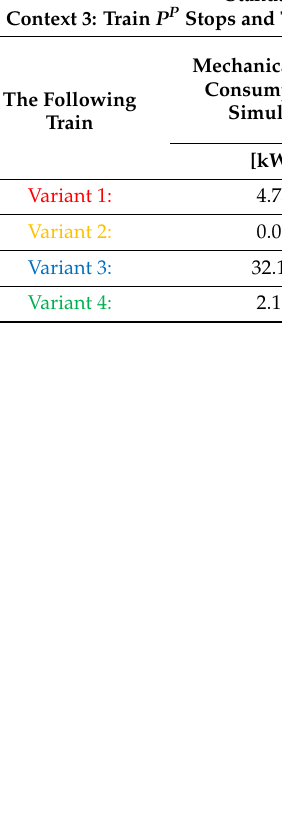
Figure 12. Distance made by train P N for different m variants; context 3 (source: own